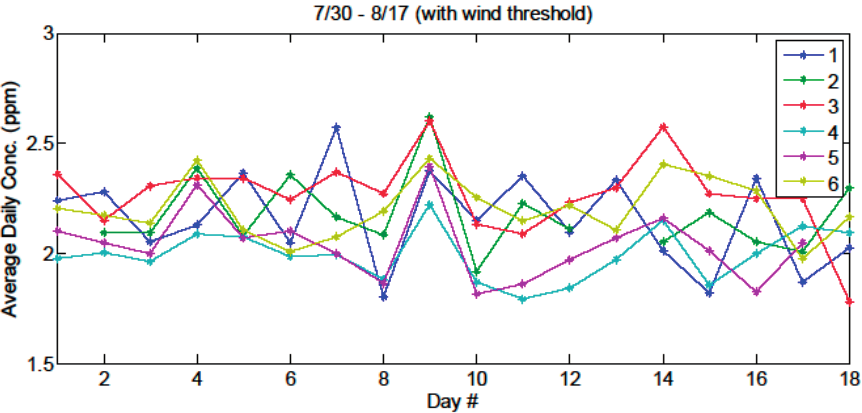
Figure 8. Average daily concentration (path normalized) acquired during low-wind conditions over 17 days of the field campaign. The data clearly illustrates distinct concentration differences between sampled optical paths (indicated with different colors). Rain and thunderstorm events occurred on day 9, and the effect of which can be seen as a clear rise in the emissions from all paths within the